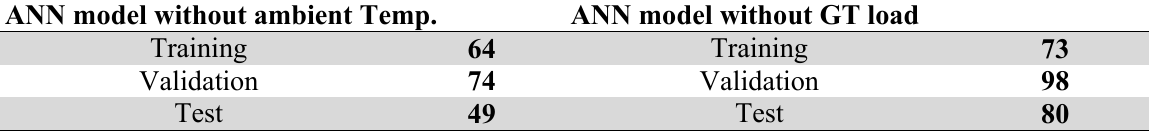
ANN model without GT load ANN model without ambient